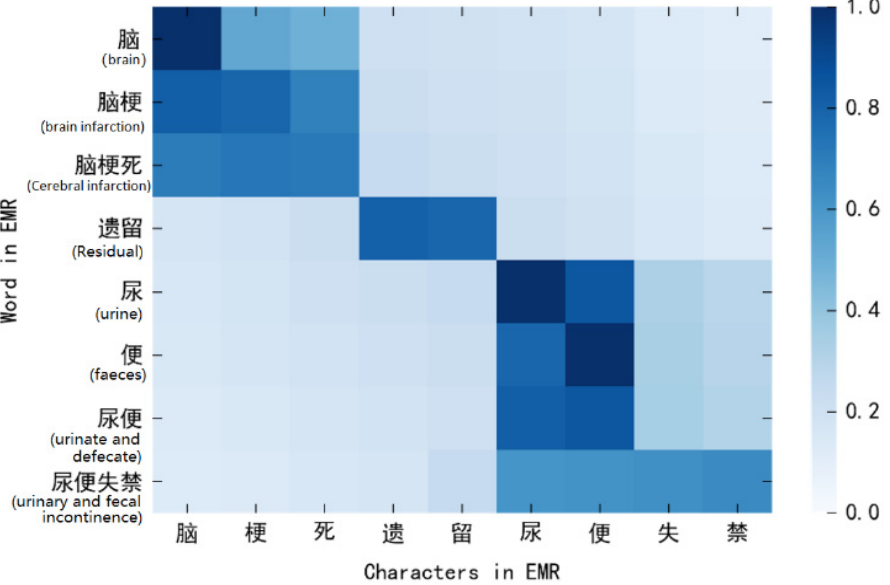
Figure 2. Correlation between word information and character information in Chinese EMR.